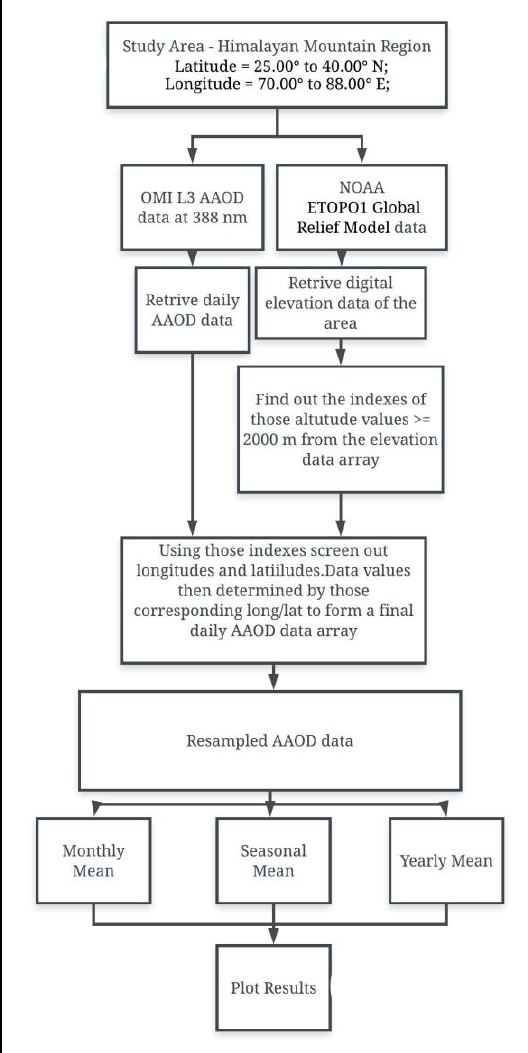
Figure 3. Seasonal mean of AAOD during DJF, MAM, JJA and SON with standard deviation. The linear trend lines for each season has also been displayed in the